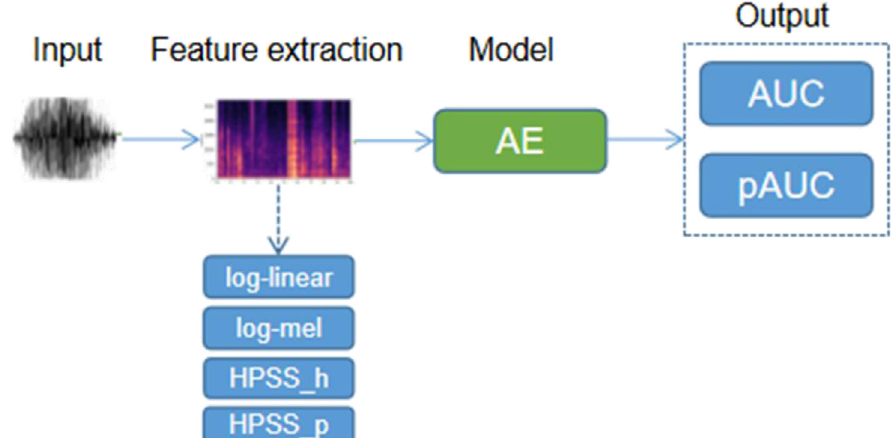
Fig. 2. The input data selects different feature extraction methods according to the corresponding relationship in Table 1, and the features are trained through AE network. During the test, the root mean square error of the reconstruction error is calculated, and the current state is obtained by comparing the threshold